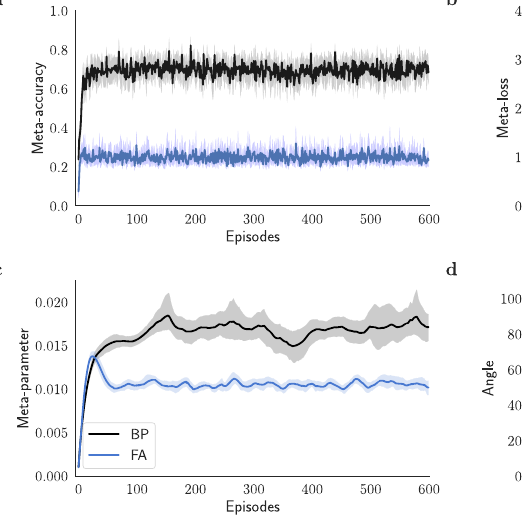
c Evolution of the learning rate meta-parameter (initialized to 10 − 3 ) with feedback alignment (FA) compared to backprop (BP) during 600 meta-optimization epi- sodes. In this fi gure, each meta-parameter was optimized separately in a single- parameter meta-optimization problem and is superimposed for comparison. d Alignment angle α ℓ between modulating signals of the feedback alignment e FA ‘ and backprop e BP ‘ for ℓ =1, 2, 3, and 4. Note that α 5 =0 (as discussed in Fig.